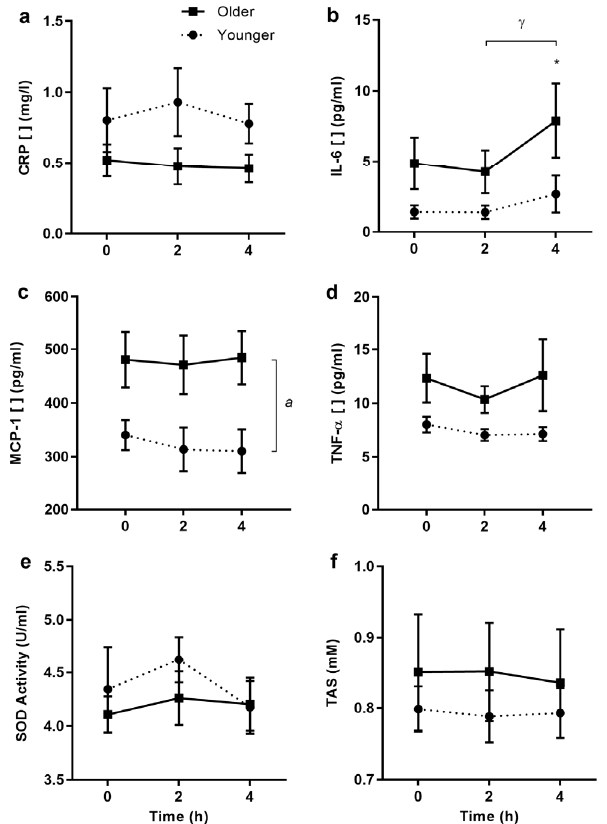
Figure 5. Circulating C-reactive protein, cytokine protein concentrations, and antioxidant status in older and younger subjects after the high-fat breakfast only. C-reactive protein (CRP), superoxide dismutase activity (SOD), and total antioxidant status (TAS, n = 15/group), and cytokine protein concentrations in older ( filled squares , n = 7) and younger adults ( filled circles , n = 6), respectively. Values represent mean ± SEM for CRP ( a ) in mg/L, IL-6 ( b ) in pg/mL, MCP-1 ( c ) in pg/mL, TNF- α ( d ) in pg/mL, SOD ( e ) in U/mL, and TAS ( f ) in mM. There were no differences in CRP, IL-6, TNF- α , SOD, and TAS responses between older and younger subjects. There were significant age differences in MCP-1 protein concentrations (age effect of p < 0.05) and changes over time for IL-6 (time effect of p < 0.01, two-factor repeated-measures ANOVA). a p < 0.05 main age difference; * p < 0.05 change from baseline; γ p < 0.01 time difference (Sidak corrected post hoc